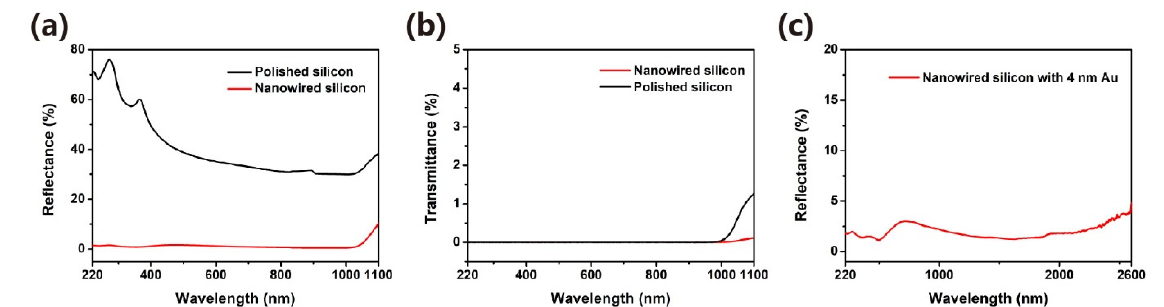
Figure 4. ( a ) The reflectance spectra of the polished silicon surface and the nanowire one; ( b ) the transmittance spectra of the polished silicon surface and the nanowire one; ( c ) the reflectance spectra of the nanowire silicon surface decorated with the Au nanoparticles that are formed by 4 nm Au film.